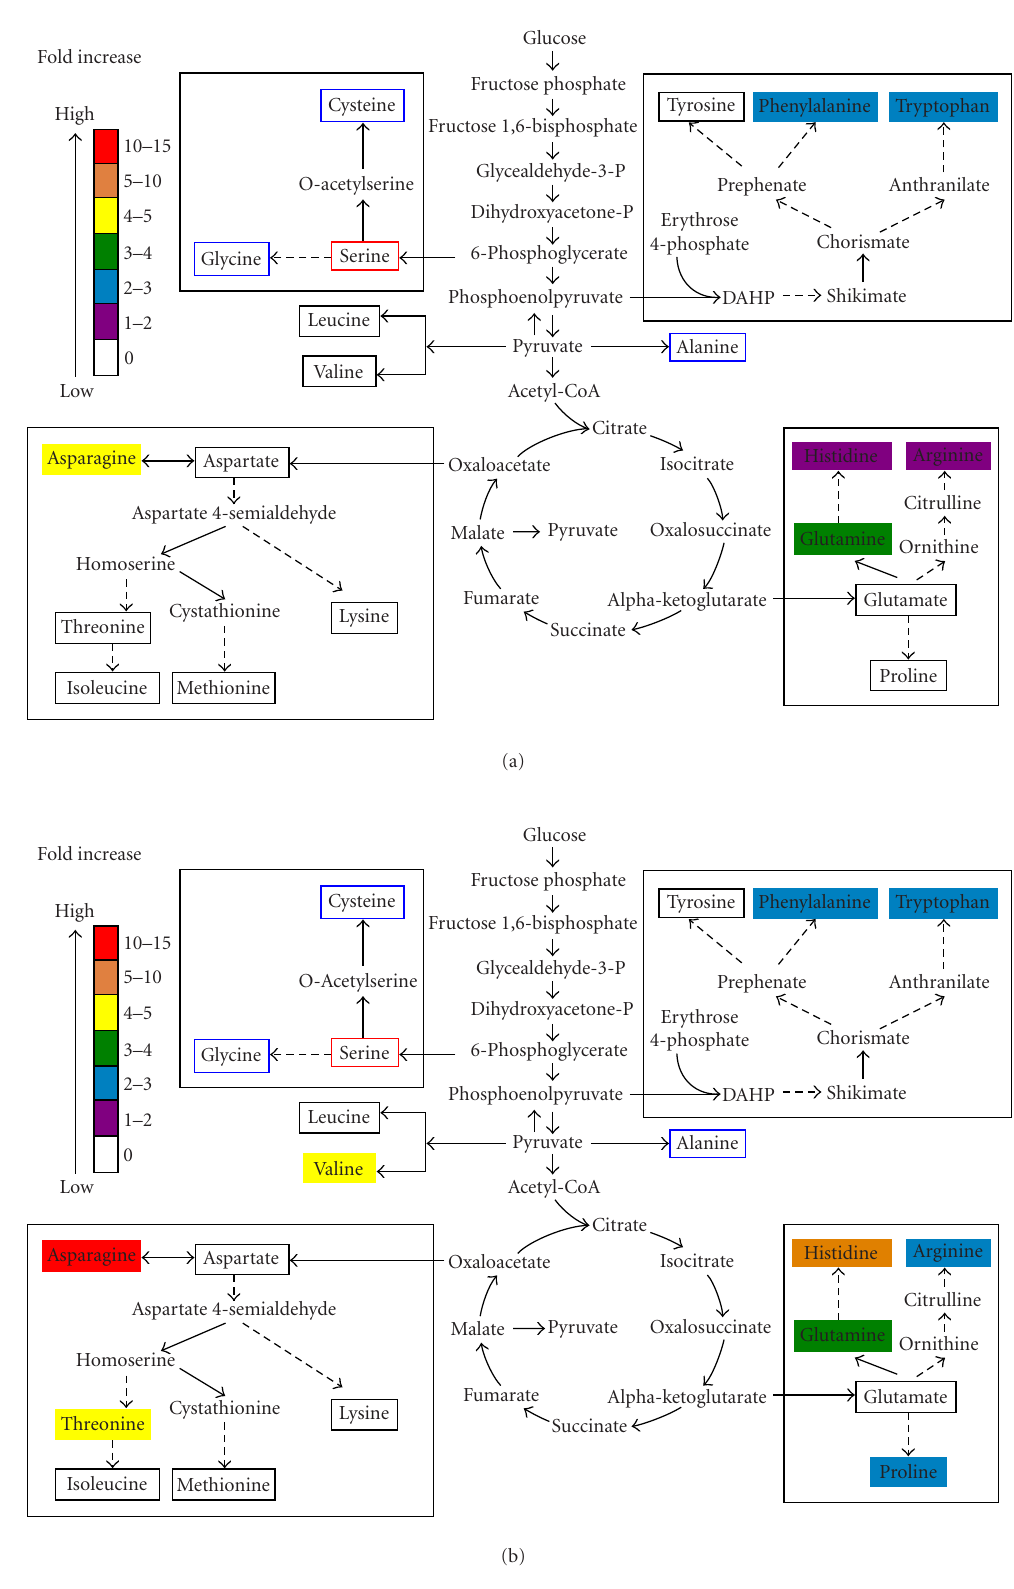
Figure 4. Metabolites in blue boxes were not detected. Metabolites in red boxes were used as internal standards and therefore detected. Metabolites in black boxes were detected and not changed. (a) Amino acids in leaves increased by gdhA . (b) Amino acids in roots increased by gdhA . Metabolites that are not protein amino acids are not annotated for changes